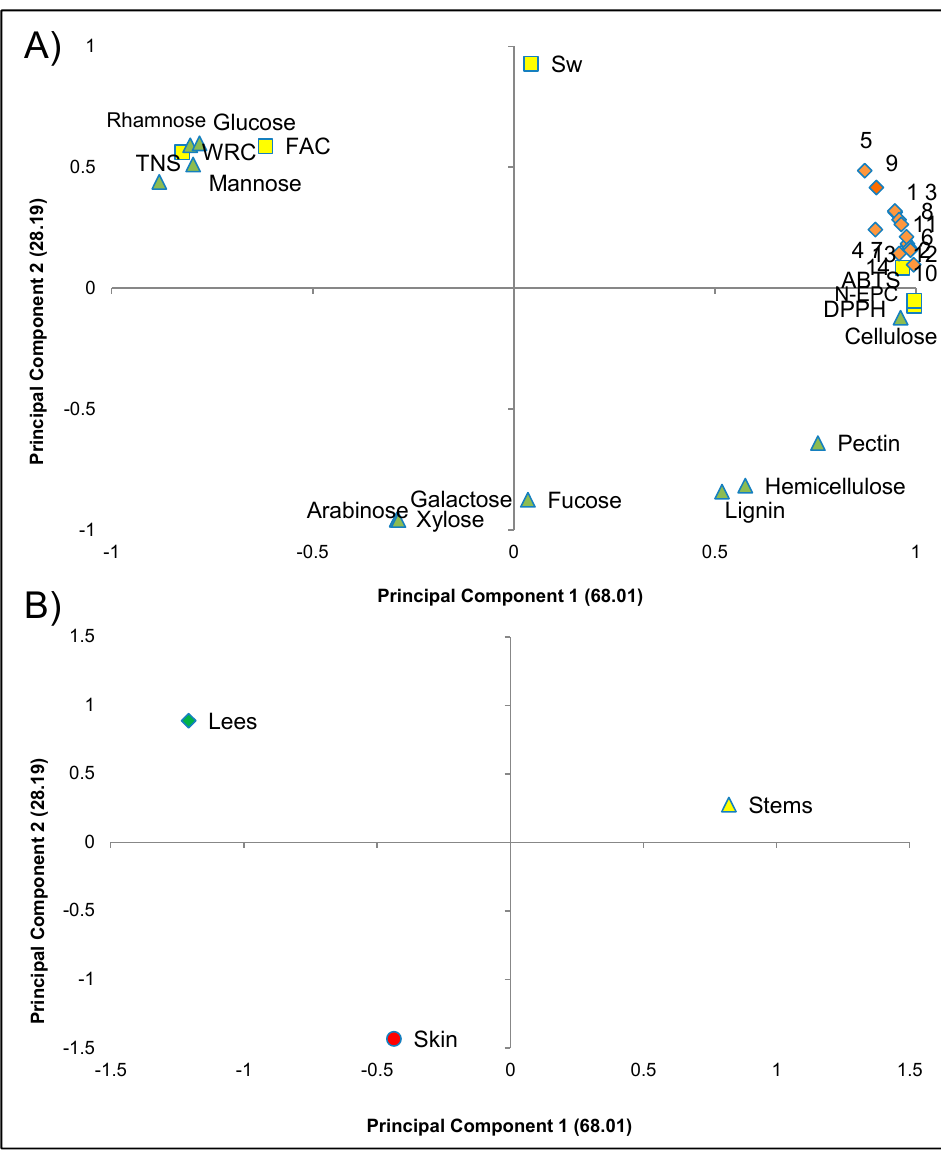
Figure 2. Principal component analysis of the analytical results of dietary fibre from skin, stems and lee samples. Loading plot ( A ). TNS, total neutral sugar; N-EPC, non-extractable phenolic compounds; DPPH and ABTS, antioxidant activity; Sw, swelling; WRC, water retention capacity; FAC, fat retention capacity; Bacterial growth: 1, Lactobacillus curvatus CECT 904; 2, Lactococcus lactis CECT 188; 3, Lactobacillus sakei CECT 5765; 4, Lactobacillus sakei CECT 980; 5, Lactobacillus brevis CECT 815; 6, Lactobacillus plantarum G1LB5; 7, Lactobacillus casei HL 245; 8, L. casei HL 233; 9, Enterococcus faecium SB 906; 10, E. faecium SB 920. Score plot ( B ). Skin, stem, and lees sample.